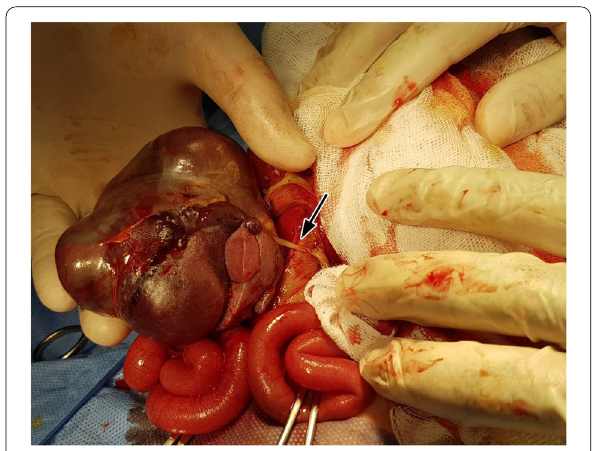
Fig. 5 The extracted fetal mass based on a main feeding vessel (black arrow)